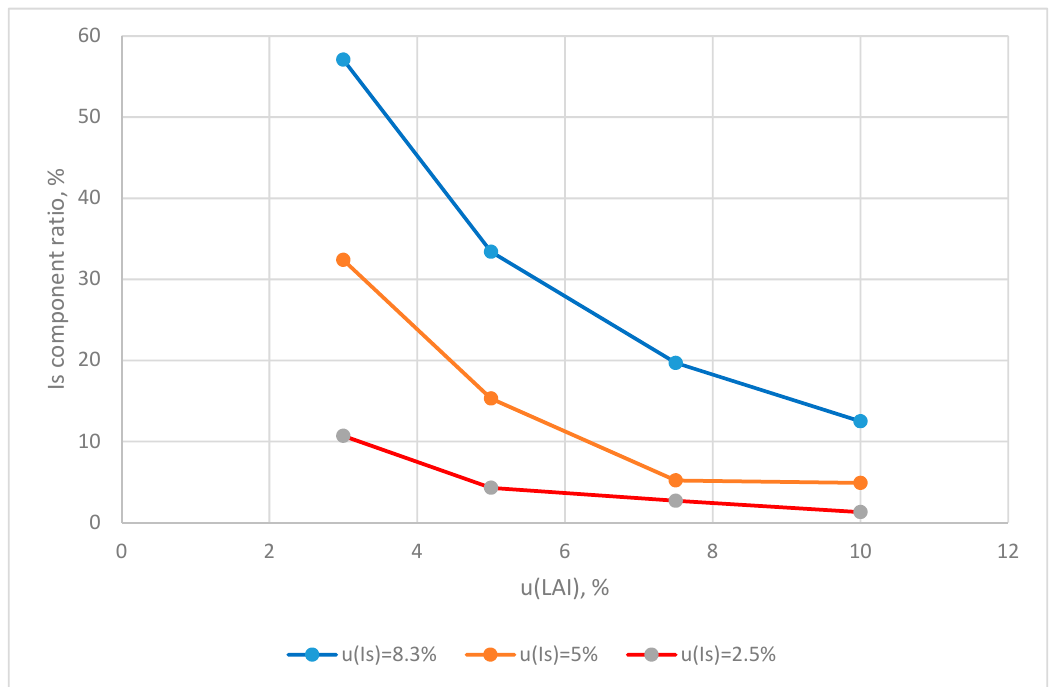
Figure 4. The effect of u(LAI) and u(Is) on the Is contribution ratio for the Baille equation.